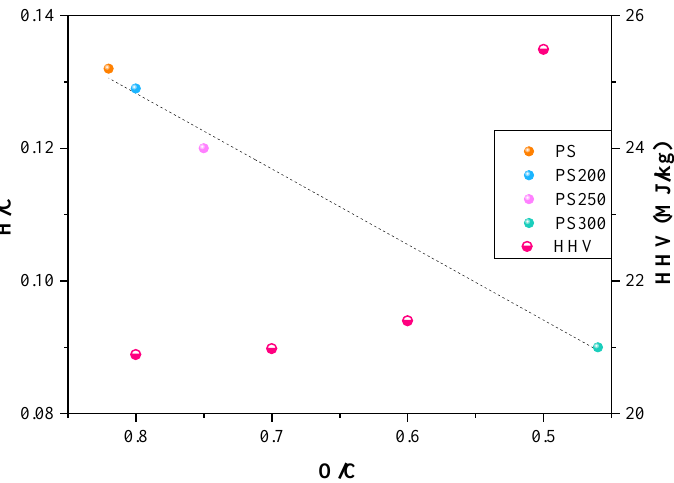
Figure 2. Van Krevelen Plot and HHV variation of raw and torrefied PS.